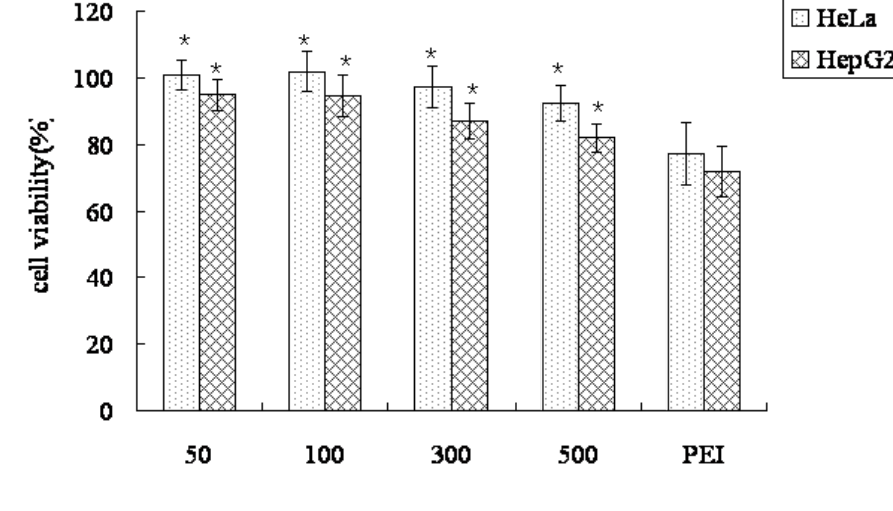
Figure 8. Cytotoxicity of various concentrations of PLA-PEG-PLL NPs/DNA complexes in HepG2 and HeLa cells. PLA-PEG-PLL NPs/DNA concentrations were from 50 μg/mL to 500 μg/mL ( n = 3, * P < 0.05 compared with